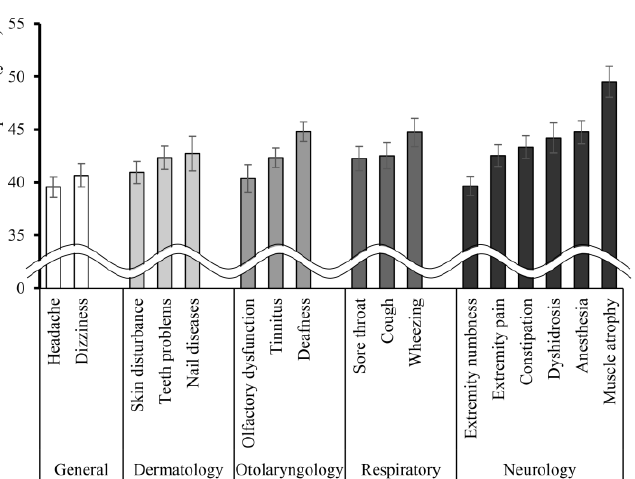
Figure 1. The duration from initial arsenic exposure to the onset of symptoms. In each category, symptoms are ordered according to the time between their onset and the initial arsenic exposure. Bar graphs are presented as mean ± SEM.